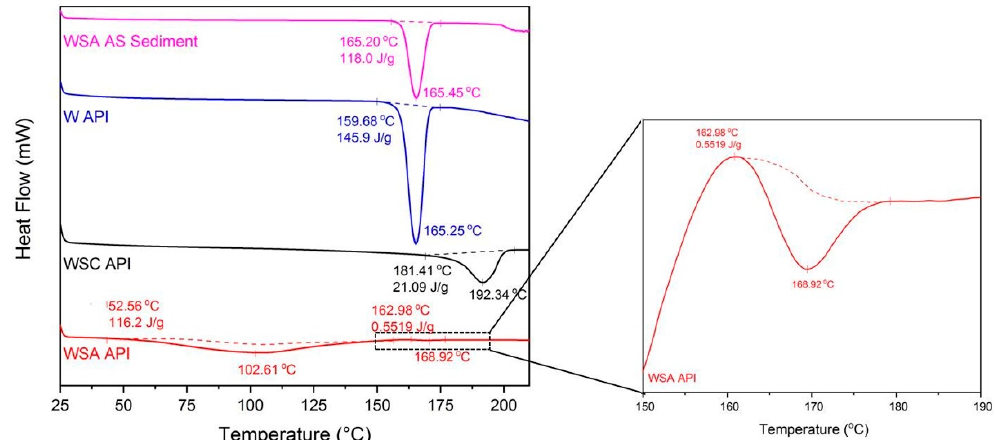
Figure 6. DSC thermograms of the sediment obtained from the aqueous solution of warfarin sodium amorphous (WSA AS), warfarin (W) API, warfarin sodium clathrate (WSC) API, and warfarin sodium amorphous API. Insert: Magnification of the warfarin sodium amorphous API thermogram in the range of 150–190 °C.